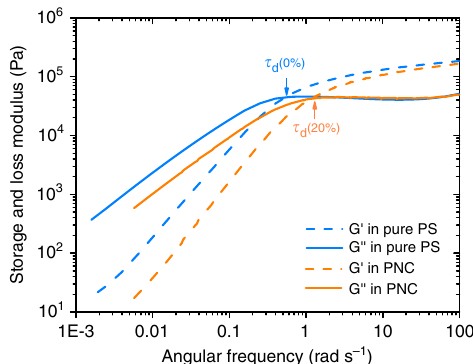
Fig. 7 Experimentally measured storage ( G 0 ) and loss ( G 00 ) modulus for both pure melt and composite system. Melt chains in both systems have a molecular weight of 202 kDa, composite contains 2% of NPs with a molecular weight of i value kink